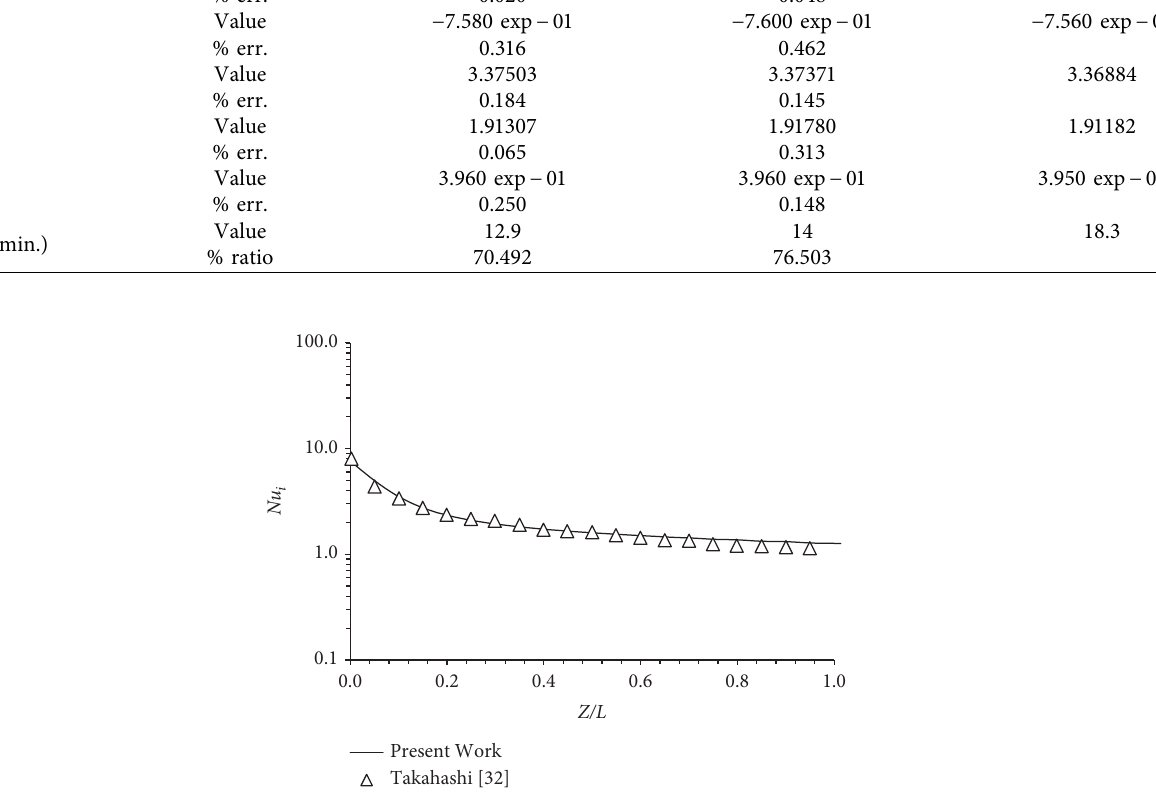
Figure 2: Results of local Nusselt number along the inner cylinder heated wall in the axial (vertical) direction compared with those of Takahashi et al. [32], K r � 1000, χ 2 � 0.64, δ i � 0.001, δ o � 0.002, N � 30, M � 30, NSI � 10, NSO �